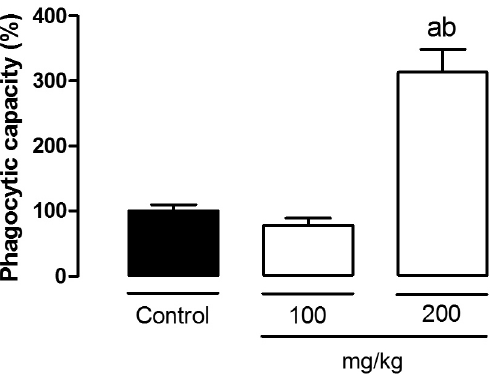
Each group represents the mean ± SEM for 6 to 10 animals. Significantly different from control group: a p <0.05. n.d., not determined. The time in seconds indicates time spent licking, flicking, and biting the injected paw.